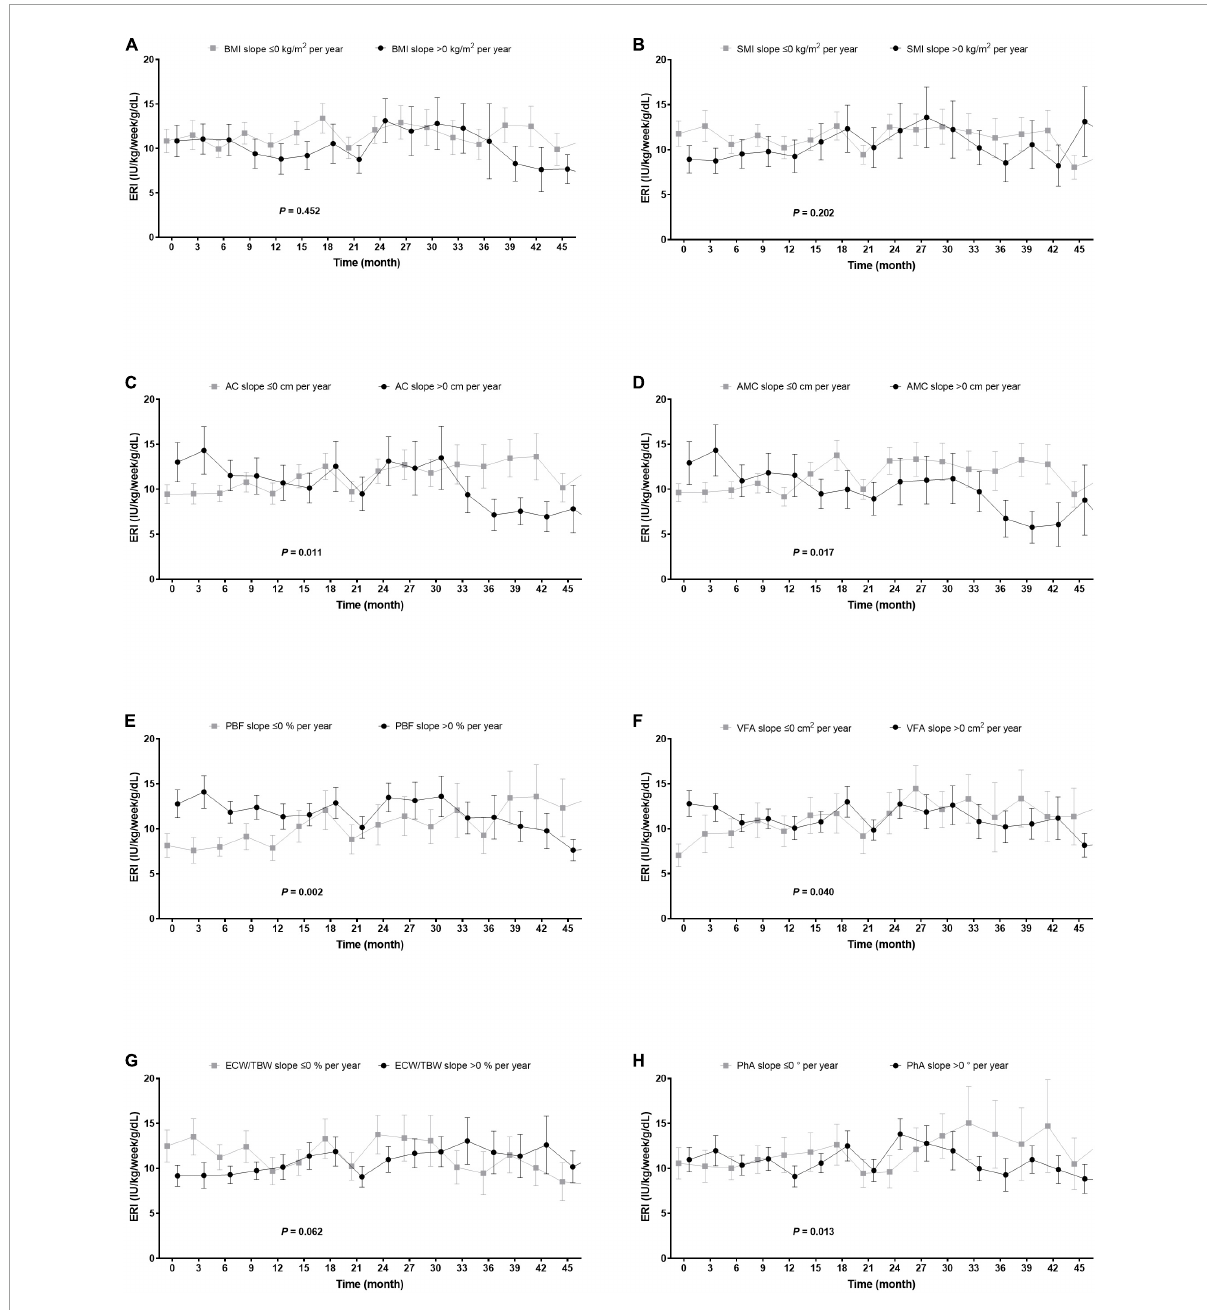
FIGURE2 Changes in ERI over time according to the slope of the body composition parameter. (A,B) The changes in ERI did not depend on the trajectories of BMI and SMI. (C–F,H) Patients who had increased AC, AMC, PBF, VFA, and PhA had reduced ERI (change in ERI: –1.4 [–2.4, –0.3], –1.4 [–2.5, –0.3], –1.7 [–2.8, –0.6], –1.2 [–2.3, –0.1], and –1.4 [–2.5, –0.3] IU/kg/week/g/dL per year; P = 0.011, 0.017, 0.002, 0.040, and 0.013). (G) However, those whose ECW/TBW had increased also experienced an increase in ERI during the study period (change in ERI: 1.0 [0.0, 2.0] /kg/week/g/dL per year; P = 0.062). The slope of each body composition parameter was estimated using the linear regression model. AC, arm circumference; AMC, arm muscle circumference; ECW/TBW, the ratio of extracellular water to total body water; ERI, erythropoiesis-stimulating agent resistance index; PBF, percent body fat; PhA, phase angle; VFA, visceral fat